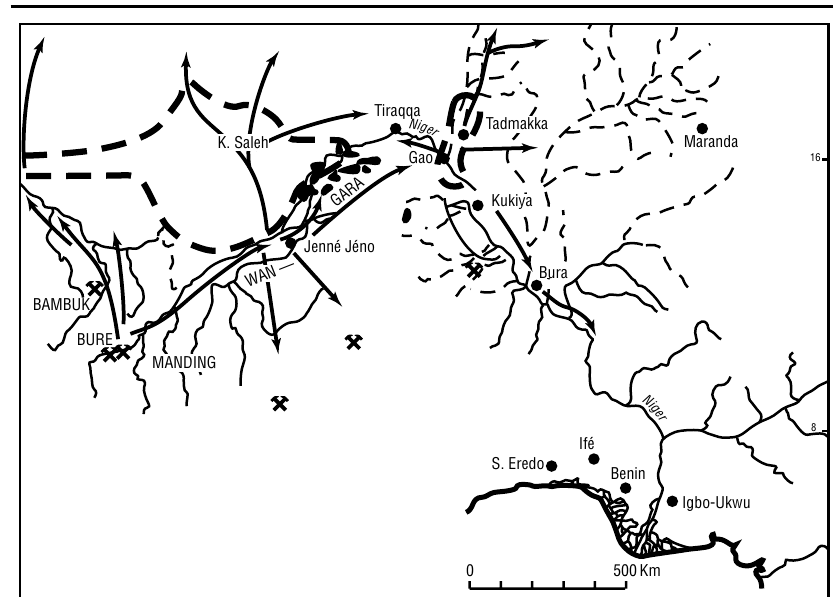
Figure 7 – The Ghana/Wagadu Tributary System (10t – 11t c.) Figure 8 – Ghana/Wagadu and Kawkaw/Gao zones of control, gold producing areas, interaction networks and Lower Niger basin centers (8t–12t